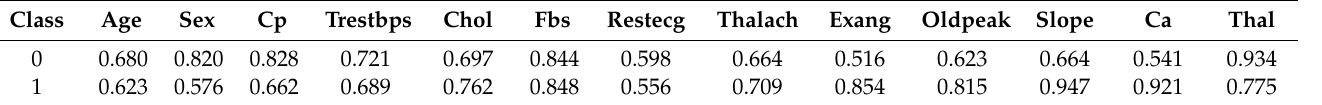
Table 11. Weights of parameters.